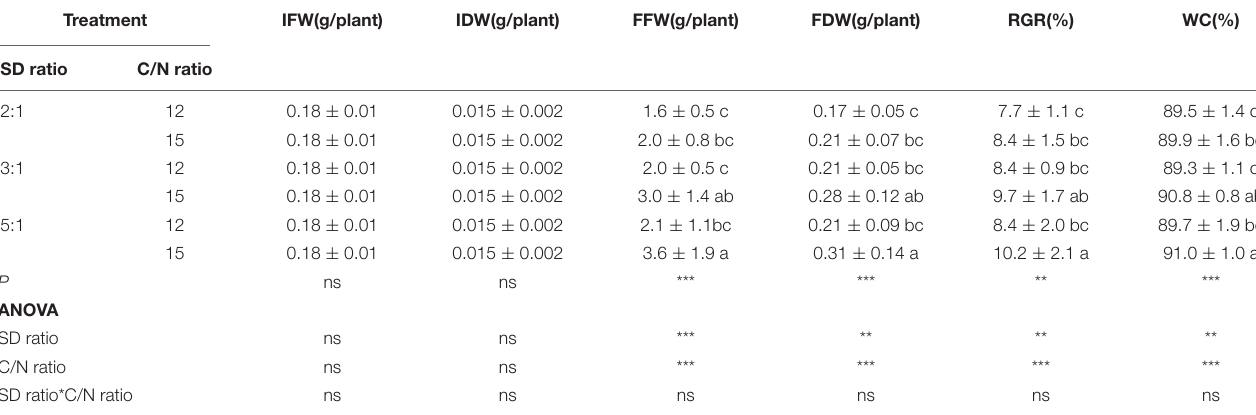
TABLE 3 | Initial fresh weight (IFW), initial dry weight (IDW), final fresh weight (FFW), final dry weight (FDW), relative growth rate (RGR), and water content (WC) of okahijiki cultivated in marine aquaponics at three stocking density ratios (SD ratio) of shrimp to plant and two C/N ratios for 4 weeks. Treatment